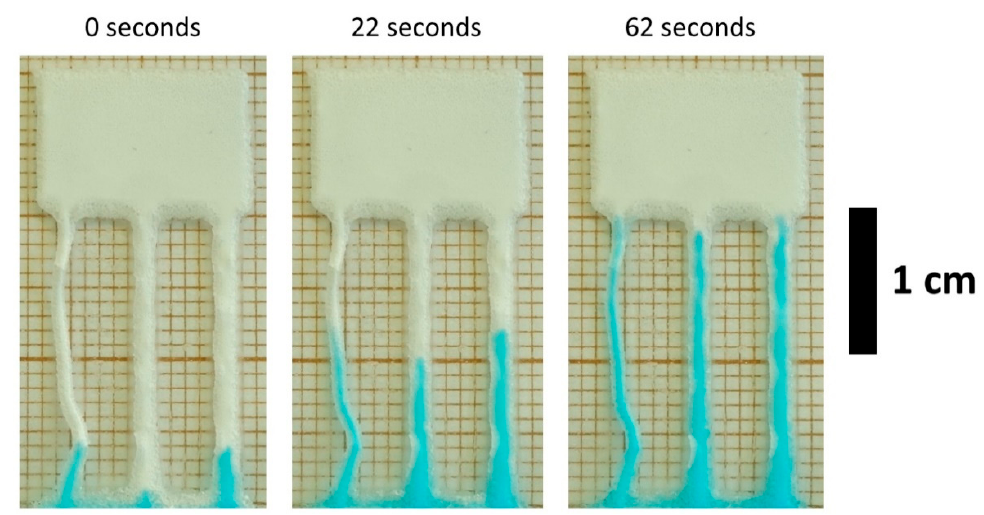
Figure 2. Example of wetting time measurements for material printed with PL method.